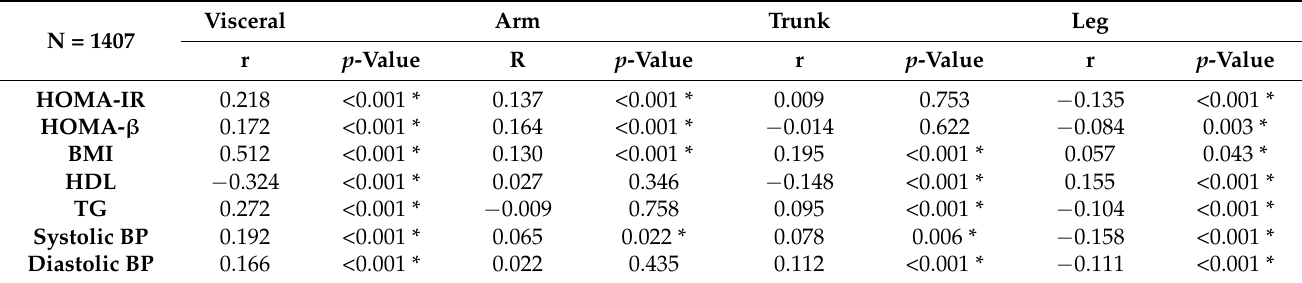
Table 9. Associations between regional adiposity and metabolic characteristics in medicated participants.